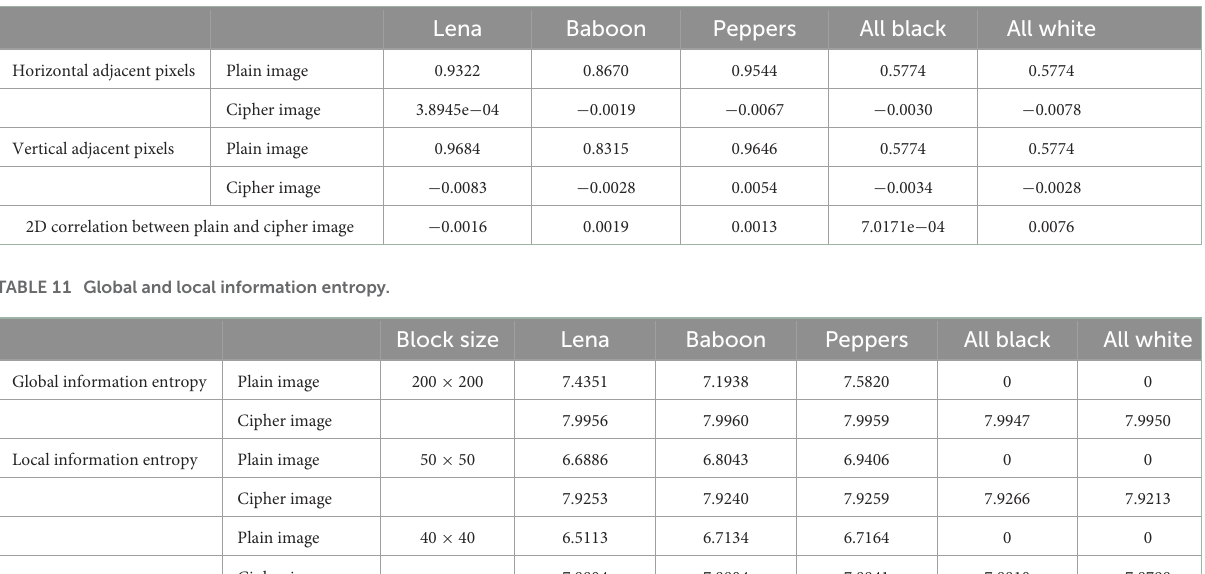
TABLE 10 Correlation between horizontally and vertically adjacent pixels in plain & cipher images and 2D correlation between pairs of plain and cipher images. Lena Baboon Peppers All black All white Horizontal adjacent pixels